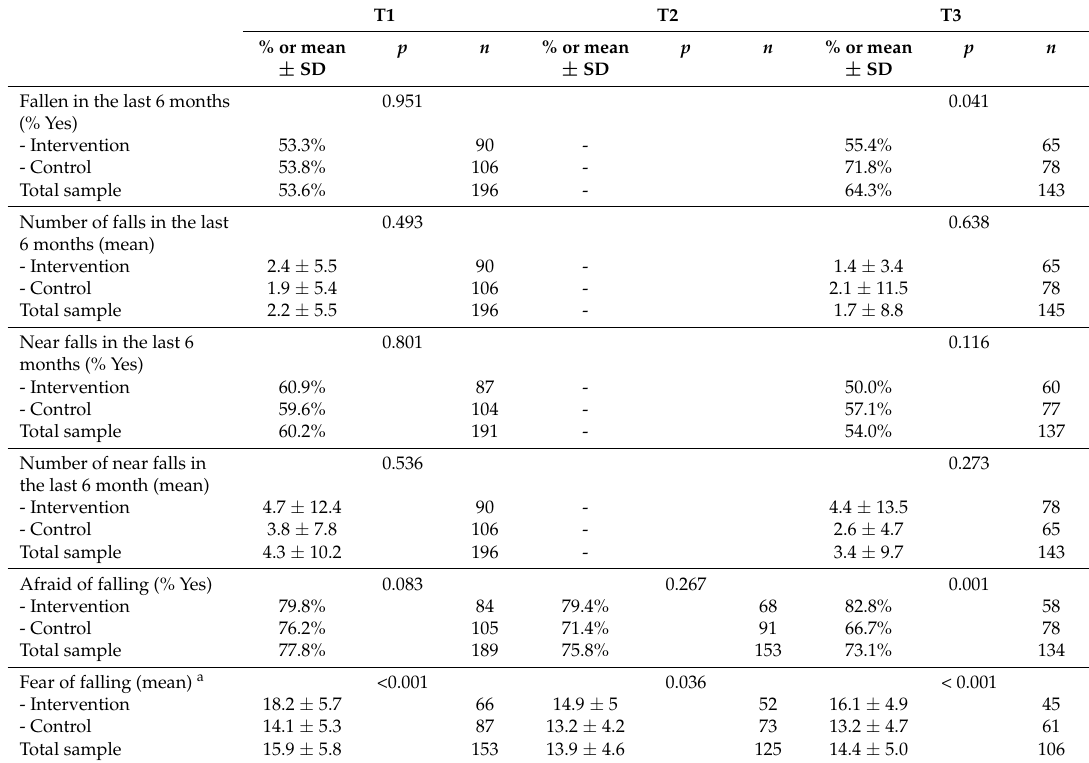
Table 2. Fall-related outcomes at baseline and follow-up at 3 and 6